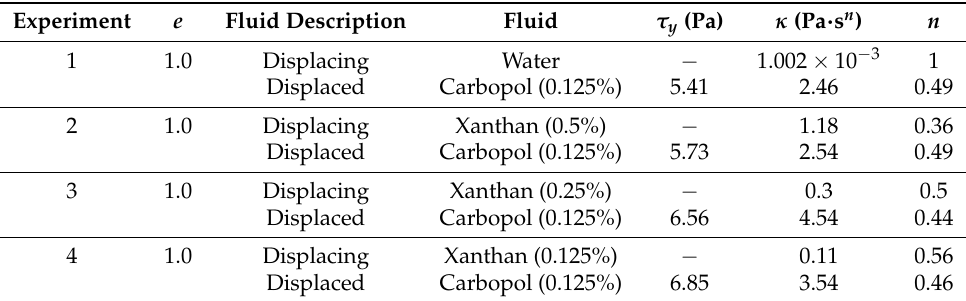
Table 2. Rheological properties. of test